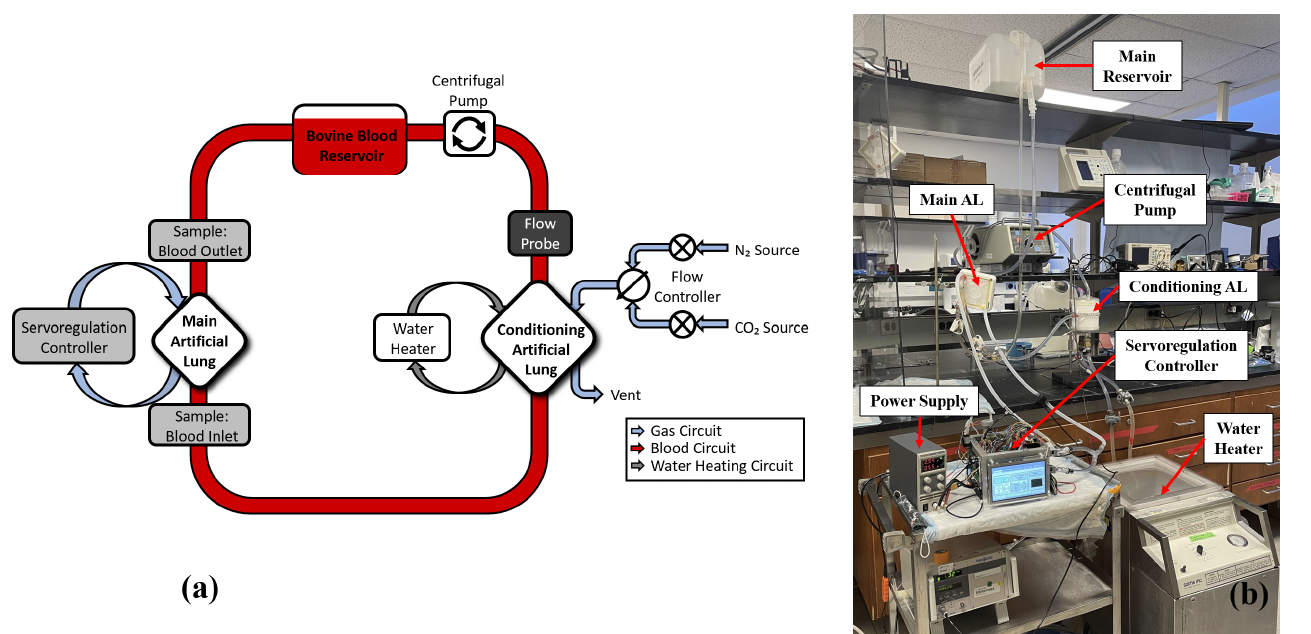
Figure 4. ( a ) Figure representing in vitro test circuit. Bovine blood in the circuit was replaced with distilled water during long-term testing. ( b ) An image showing the in vitro testing setup with main components